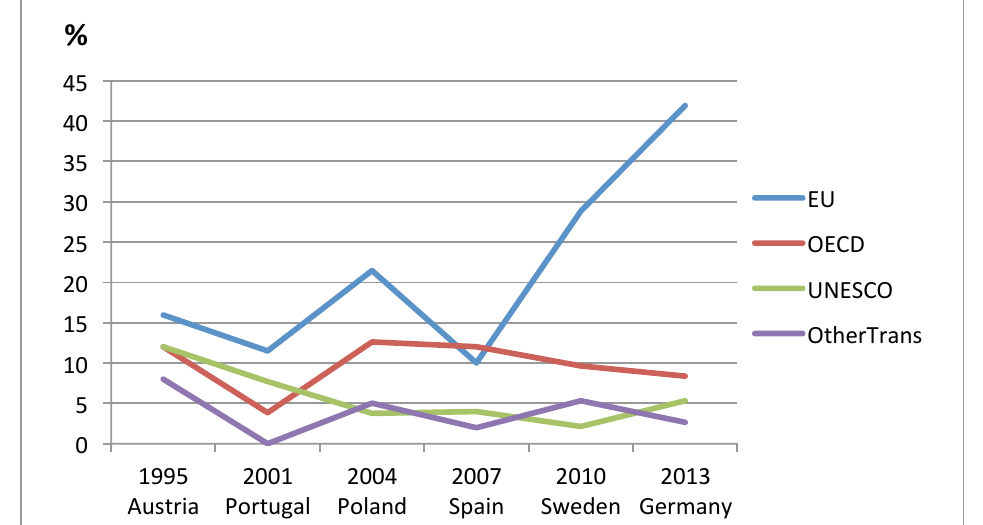
Figure 3: ESREA conferences and the citation rates of different policy documents over